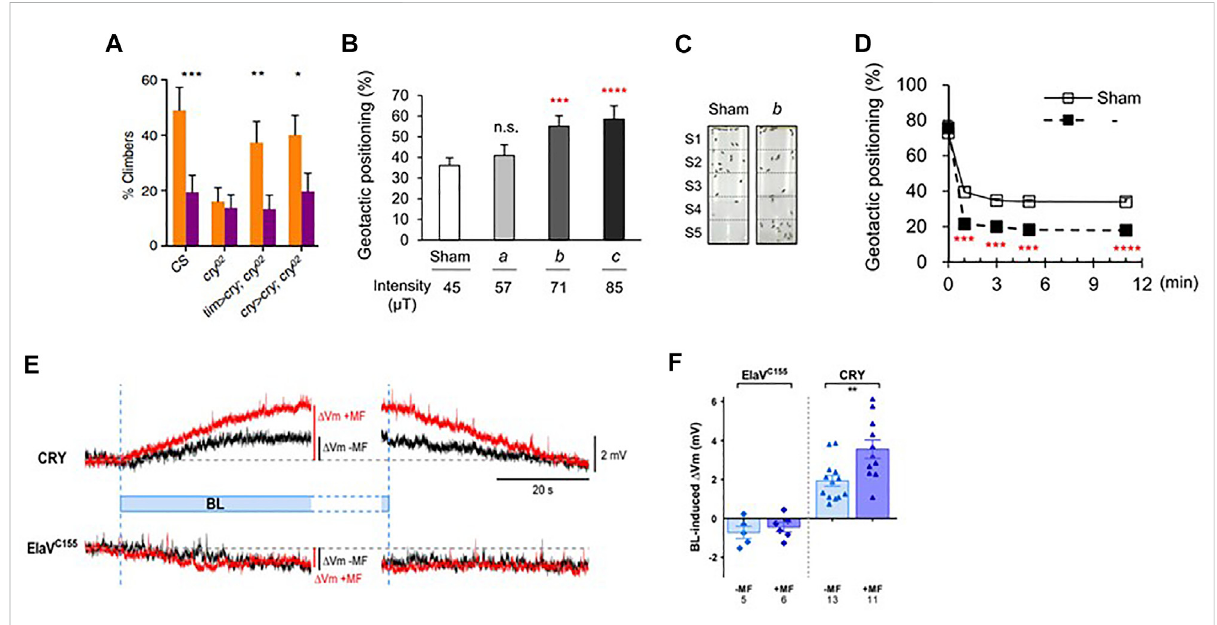
FIGURE 3 MF exposure effects on geotaxis and neuronal fi ring in Drosophila . (A) Results of geotaxis assay from Fedele et al. (2014b). Under 450 nm blue light wild-type Canton S (CS) fl ies walk upwards (negative geotaxis), but application of a MF makes them more positively geotactic generating a signi fi cantly lower climbing score as they tend to move downwards. cry 02 mutants show reduced negative geotaxis, so application of a MF does not changetheirbehaviour,thereforeasincircadianbehaviour(Figure2D)thisresultisnotinformativewithrespecttotheMF.However,expressing CRY in a mutant cry 02 background either in all clock neurons ( tim > cry ) or just those that normally express CRY ( cry > cry ) , rescues the normal negativegeotacticresponseinshamexposed fl ieswhichissigni fi cantlyreducedinMFexposed fl ies.Meansandsemsshown.Flieswereexposedtoa static 500 μ T MF in dim blue light.*, p < 0.05, ** p < 0.01, *** p < 0.001. (B,C) . Results of similar experiment as in A by Bae et al (2016). Geotactic positioning (positive geotaxis) in a tube, verysimilar to that used by Fedele et al., 2014b (see above, A) and shown in C, at different MF intensities. The graph shows means and sems for fl ies exposed to the earth ’ s ambient fi eld (sham, 45 μ T in Korea) with increasing intensity of exposure. In this case, theresultsarerepresentedasthe fl ies ’ positivegeotaxisscore(% fl iesinlowerS2-S5sectionsoftubeshowninC,sohigherscoresmeansthe fl iesare moving further downwards). As fi eld intensity increases, fl ies move further downwards generating a higher geotactic score, as observed in Fedele et al, 2014a) . *** p < 0.0005, **** p < 0.0001 compared to sham. (D) Geotaxis in a near zero fi eld (Bae et al., 2016). Geotaxis was compared in a zero (labelled ‘ b ’ see C) versus ambient 45 μ T (sham) fi eld. The ambient (sham, 45 μ T) fi eld signi fi cantly enhanced positive geotaxis (open squares) compared to zero fi eld ( fi lled squares), so fl ies moved higher in zero fi eld, in contrast to the downward (positive geotactic) effect of the ambient MF on geotaxis. *** p < 0.0005, **** p < 0.0001. Figures (B – D) reused under open access creative commons license (http://creativecommons.org/ publicdomain/zero/1.0/). (E,F) Magnetic fi eld effects on neuronal fi ring in Drosophila larval aCC neuron (reproducedfrom Figure 1 inGiachello et al., 2016 under creative common license). (E) Representative electrophysiological recordings from a larval aCC neuron expressing CRY ectopically by using the pan-neuronal elavgal4 driver driving UAS-dcry (labelled ‘ CRY ’ ) compared to control ( elavGAL4 driver only). Blue light produces signi fi cant reversible depolarization in membrane potential ( Δ V m , Y-axis, black trace) that is potentiated by a 100 mT MF (red trace). The elavgal4 driver control generatesanincreaseddepolarisationtoBL(black)butnoenhancementbytheMF(red). (F) Theresultsfromagroupoflarvaeareshown. Meansand sems ** p <